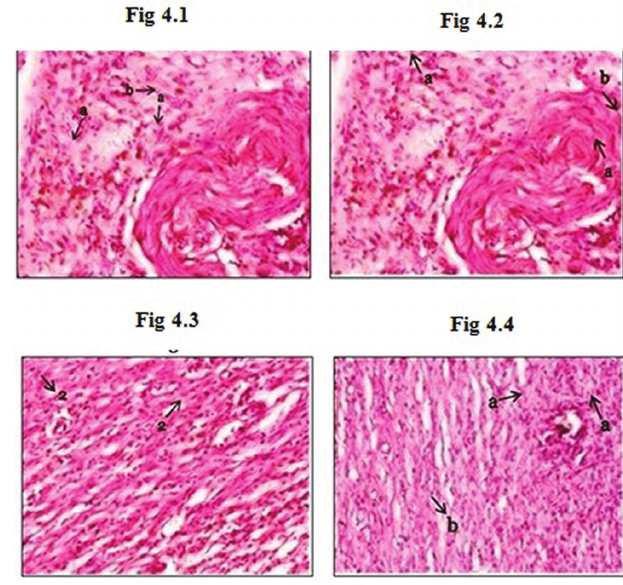
FIGURE 4 - Histological